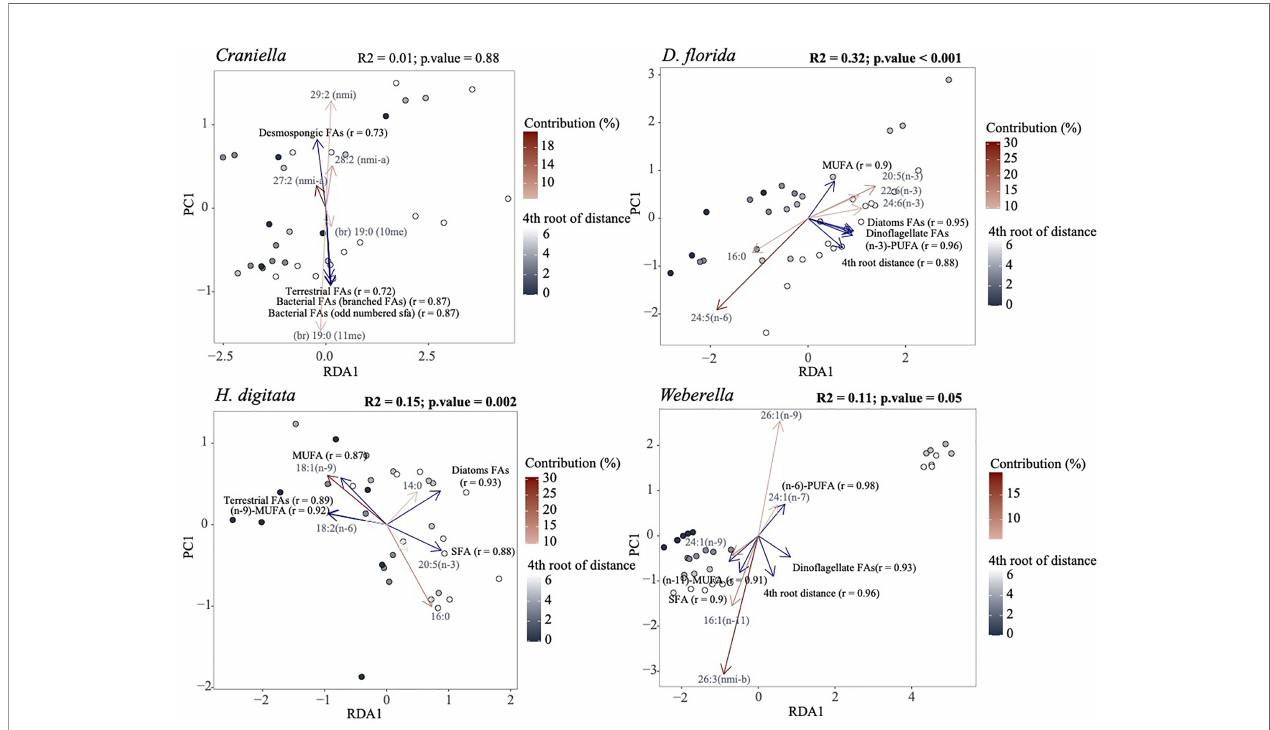
FIGURE 11 | Redundancy analysis (RDA) of the fatty acid pro fi les per epibenthic species using the 4 th root of distance from farm as explanatory variable. The fi ve most important response variables (fatty acids) are overlaid as red arrows with shade corresponding to their contribution. Variables of particular interest, including distance from farm, were also fi tted (blue arrows) using the ‘ env fi t ’ function of the ‘ vegan ’ R package. Only the fi ve most correlated variables to the ordination are displayed. Results of a permutational analysis of variance (PERMANOVA; 9,999 permutations) testing the effect of 4 th root of distance from farm are displayed at the upper right corner of each facet, with signi fi cant relationship highlighted in